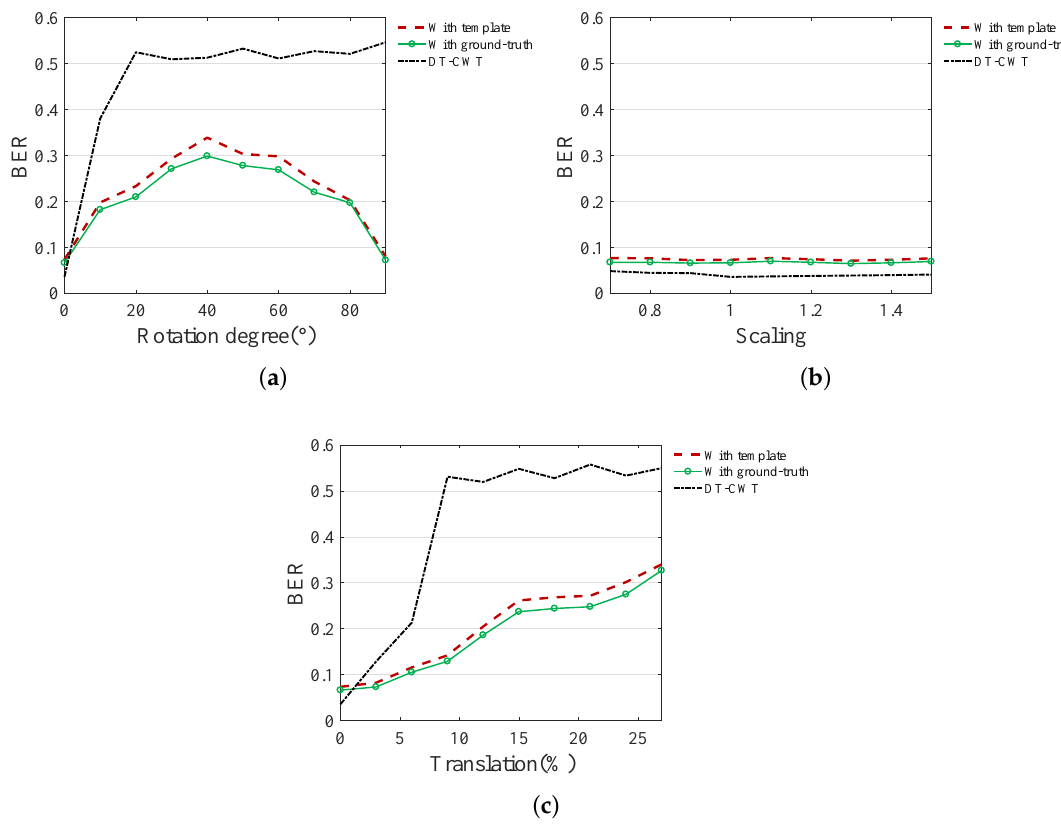
Figure 10. Average BER for RST attack with DIBR rendering. ( a ) rotation, ( b ) scaling, ( c )